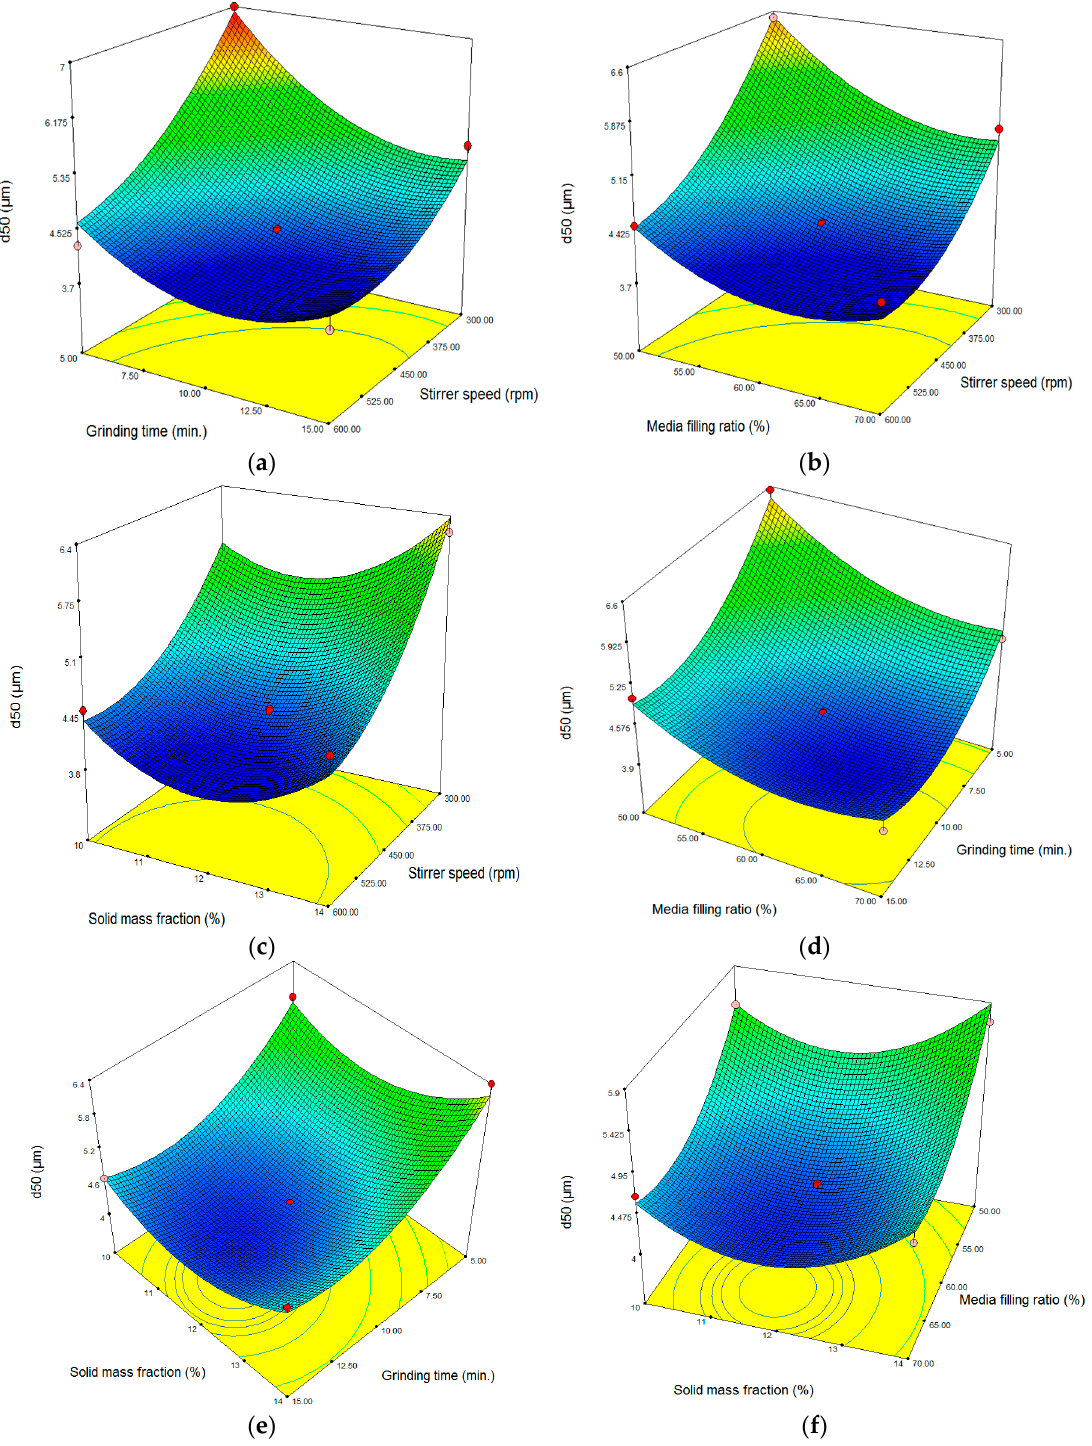
Figure 4. Response surface plots of d 50 (µm) as a function of: ( a ) grinding time (min) and stirrer speed (rpm); ( b ) media filling ratio (%) and stirrer speed (rpm); ( c ) solid mass fraction (%) and stirrer speed (rpm); ( d ) media filling ratio (%) and grinding time (min); ( e ) solid mass fraction (%) and grinding time (min); ( f ) solid mass fraction (%) and media filling ratio (%).